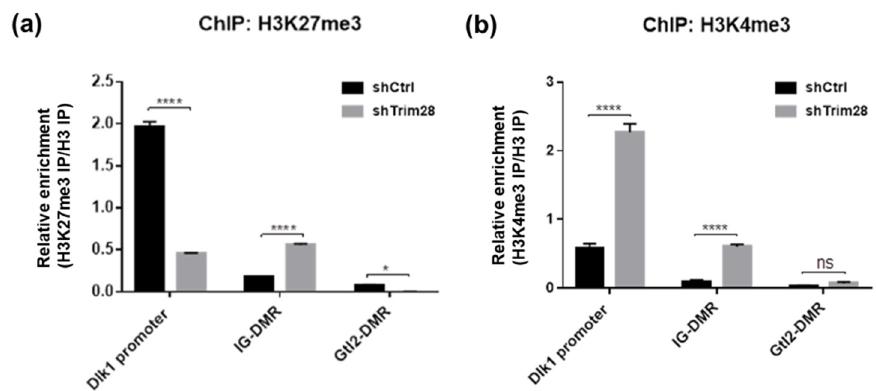
Figure 6. ChIP-qPCR analysis of Dlk1 promoter, IG-DMR and Gtl2-DMR. ChIP was performed in control and Trim28 KD 3T3-L1 cells by antibodies against H3K27me3 ( a ) and H3K4me3 ( b ). The precipitated genomic DNA was analyzed by qPCR with primers as indicated. The sequences of qPCR primers for ChIP are listed in Table S3. The relative enrichment was shown by normalized with histone H3 IP. Data were representative of three replicate experiments. The data were estimated by two-way ANOVA, **** p < 0.0001, * p < 0.05, ns: not significant.